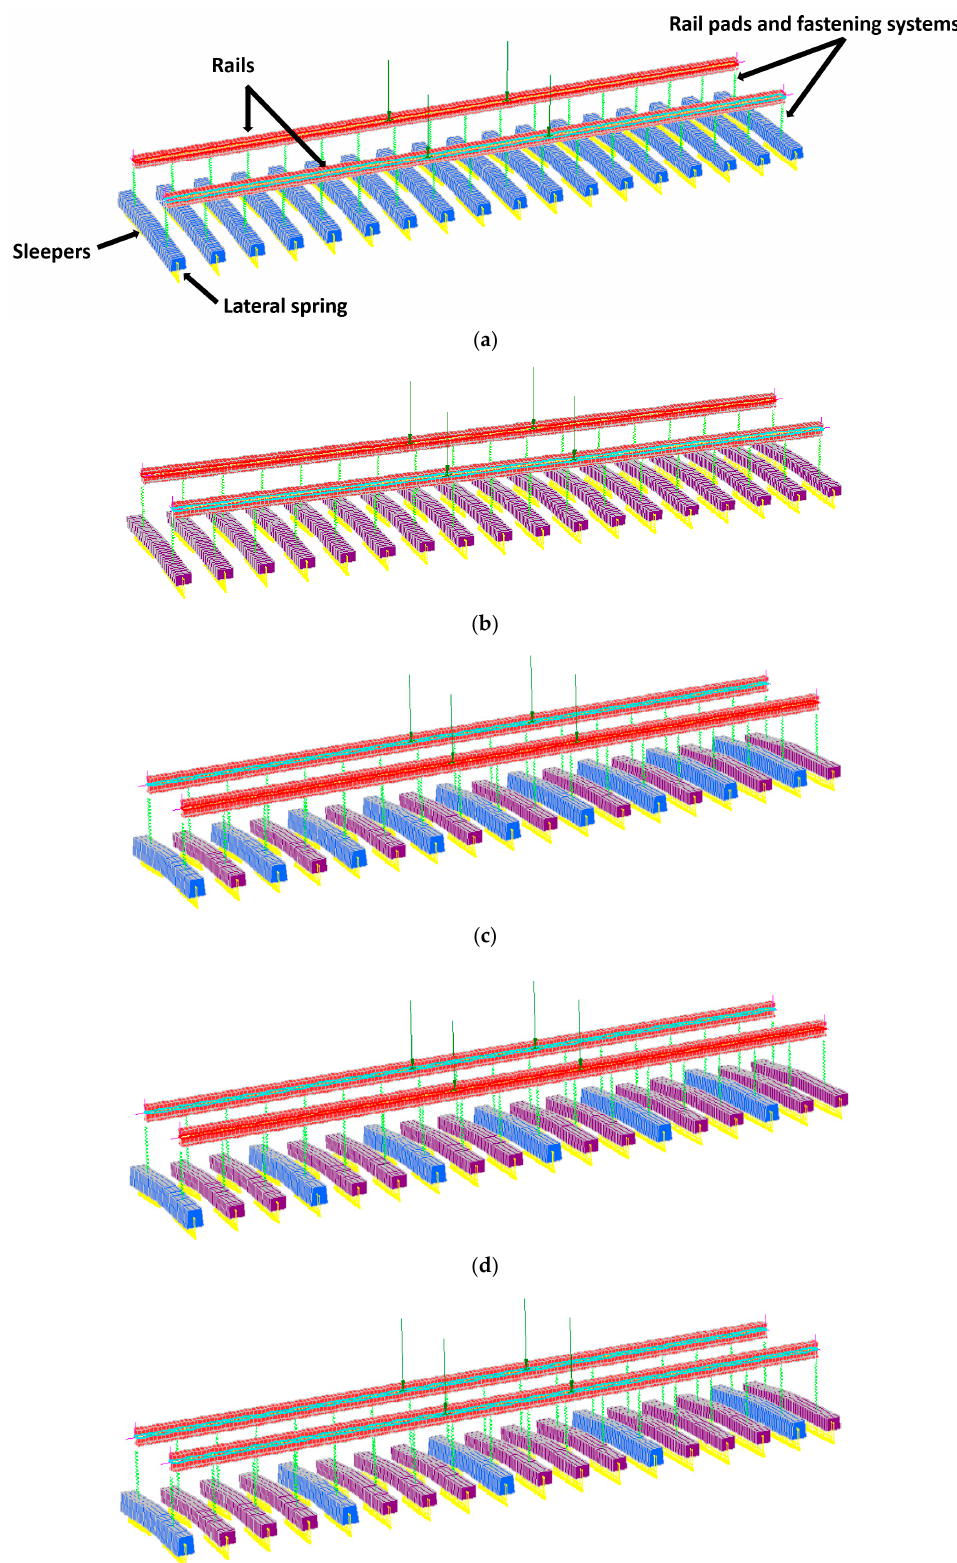
Figure 2. Railway track models: ( a ) concrete track; ( b ) timber track; ( c ) “1 in 2” interspersed track; ( d ) “1 in 3” interspersed track; ( e ) “1 in 4” interspersed track.